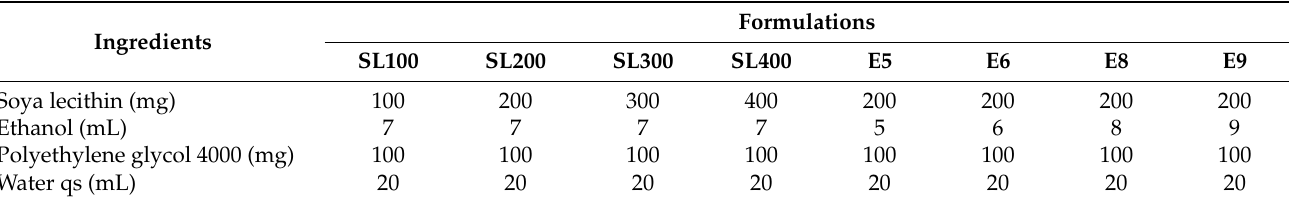
Table 1. Formulation of blank